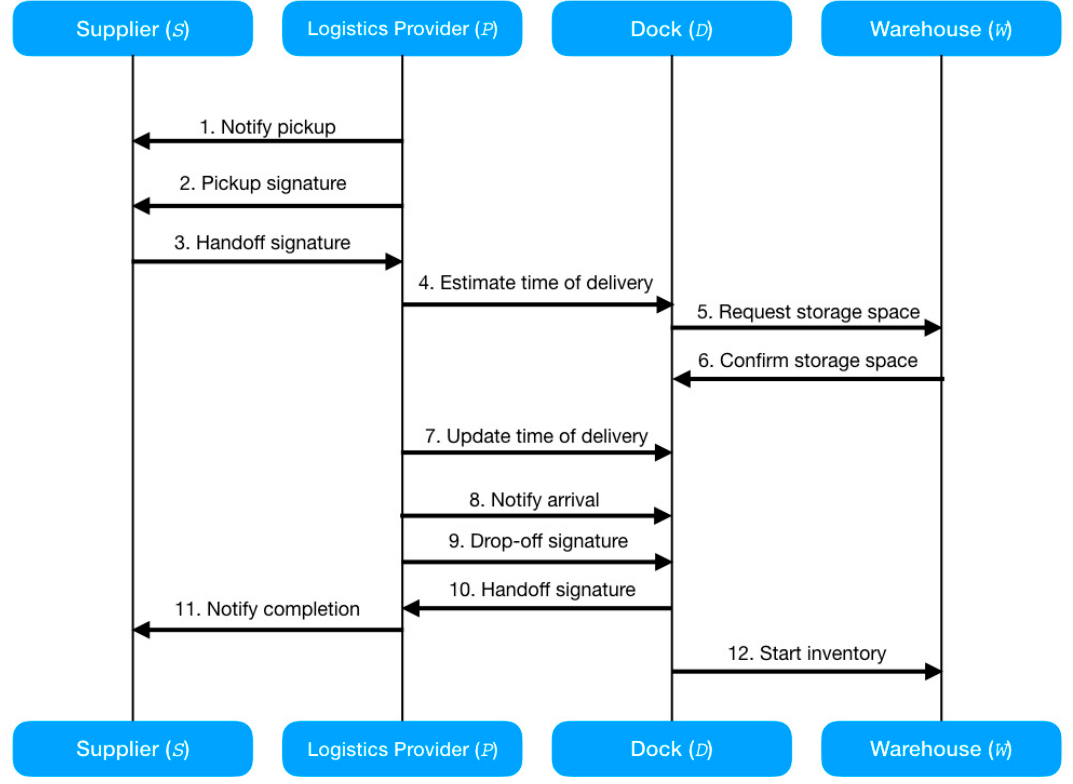
Figure 7. Pickup, shipping and delivery in TransICE.